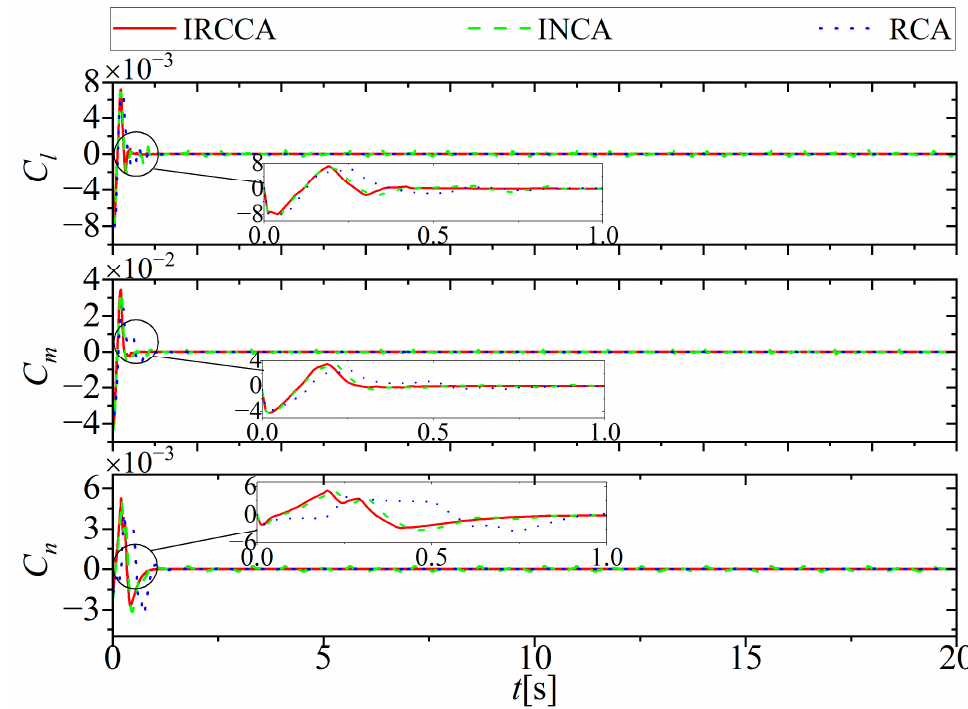
Figure 11. Time response of the moment coefficient with loose fault.